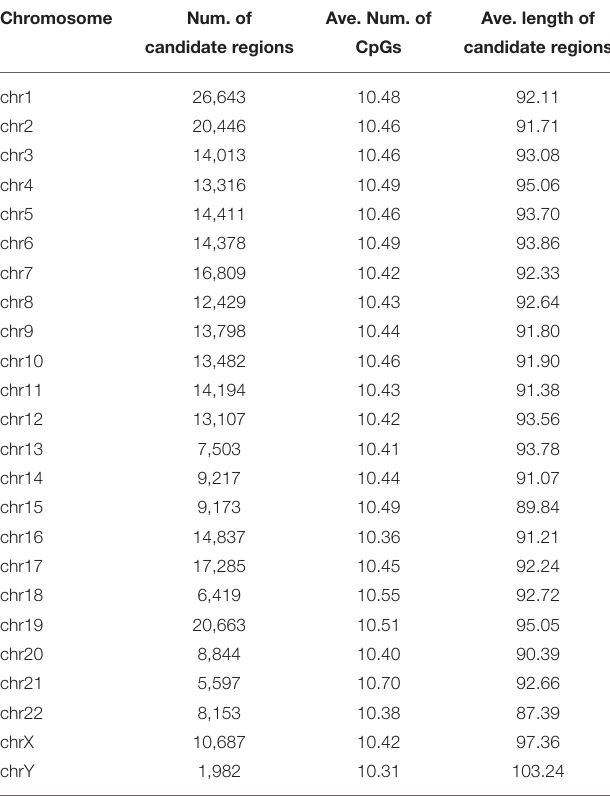
TABLE 1 | The number, the average number of CpGs, and the length of candidate regions in each chromosome. Chromosome Num. of Ave. Num. of Ave. length